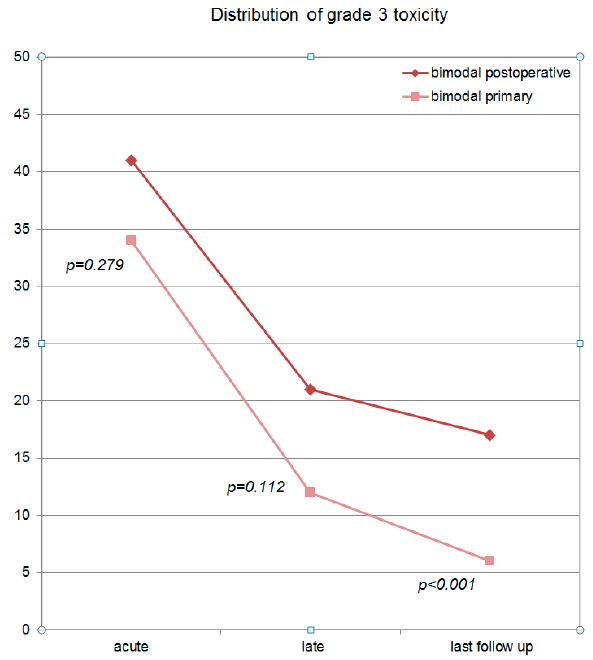
Figure 4. Distribution of grade 3 toxicity (acute, late and at last follow-up) for the postoperative bimodal and the primary bimodal RT group. Postoperative bimodal RT results in significant more grade 3 toxicity over time ( p < 0.01).